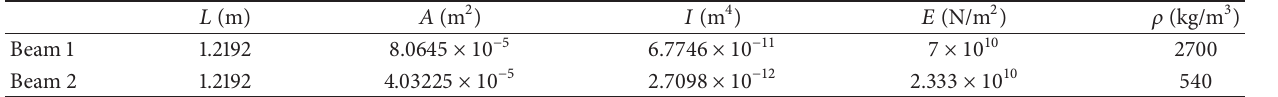
Table 1: Parameters of double beams.